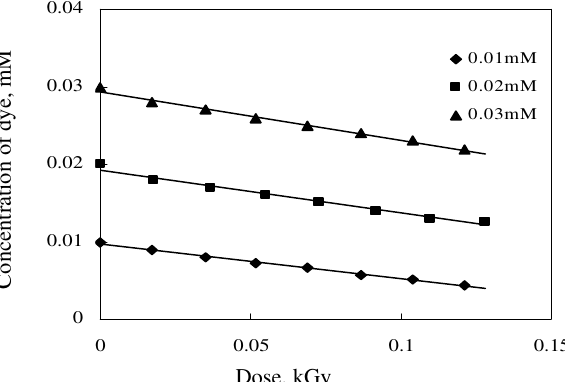
Figure 1. The graphs depicting radiolytic degradation of pure aqueous congo red dye solutions of 0.01, 0.02 and 0.03